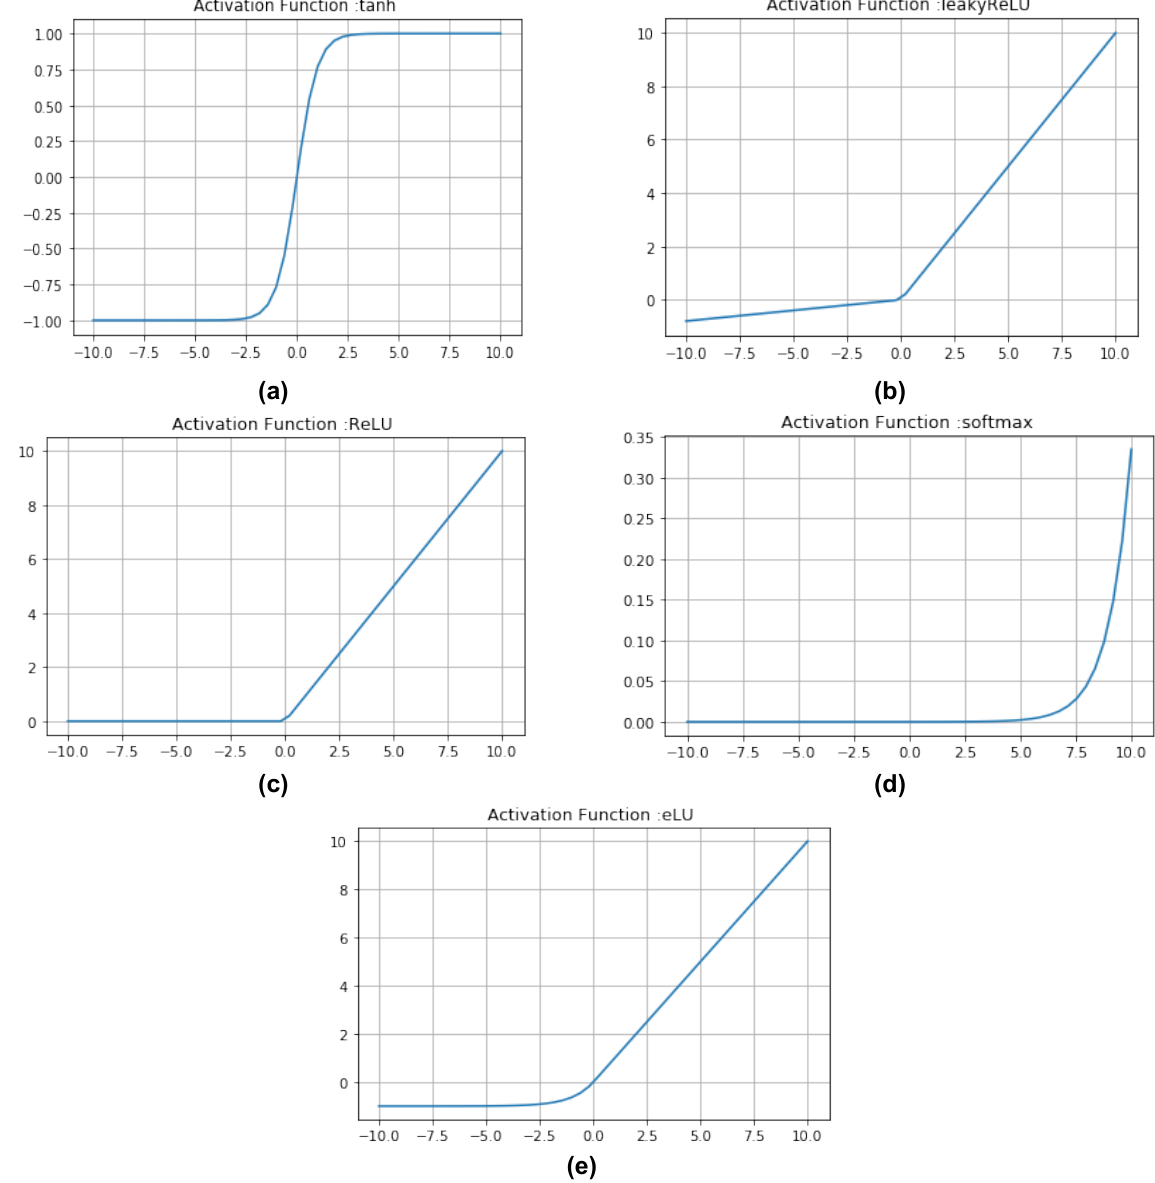
Figure 7(a). A representation of hyperbolic tangent activation function; (b). Leaky Rectified Linear Unit activation function; (c). A representation of Exponential Linear Unit activation function; (d). A representation of Rectified Linear Unit activation function; and (e). A representation of Softmax